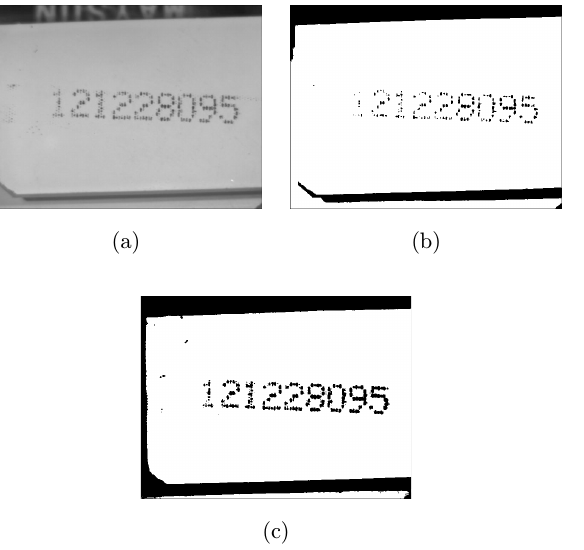
Fig. 4. Binary image with OTSU threshold and adjusted threshold respectively. (a) Captured raw image, (b) binarized by OTSU threshold and (c) binarized by adjusted threshold.